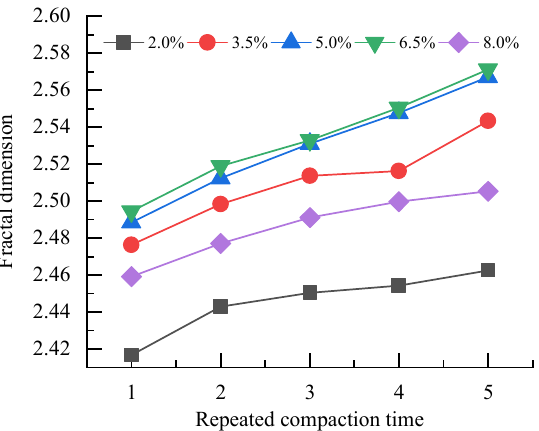
Figure 8. Distribution of fractal dimension against the repeated compaction time.